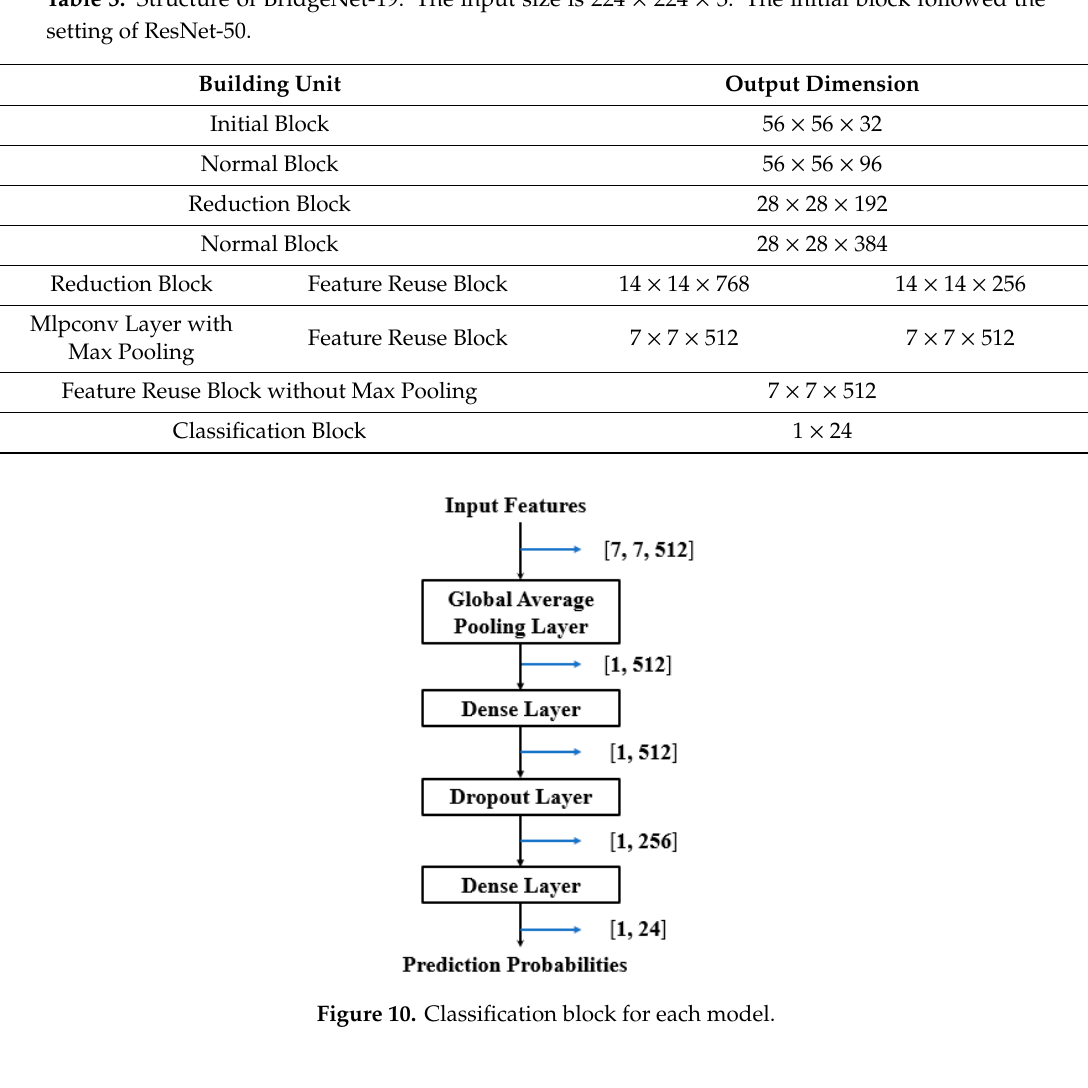
Table 3. Structure of BridgeNet-19. The input size is 224 × 224 × 3. The initial block followed the setting of ResNet-50.